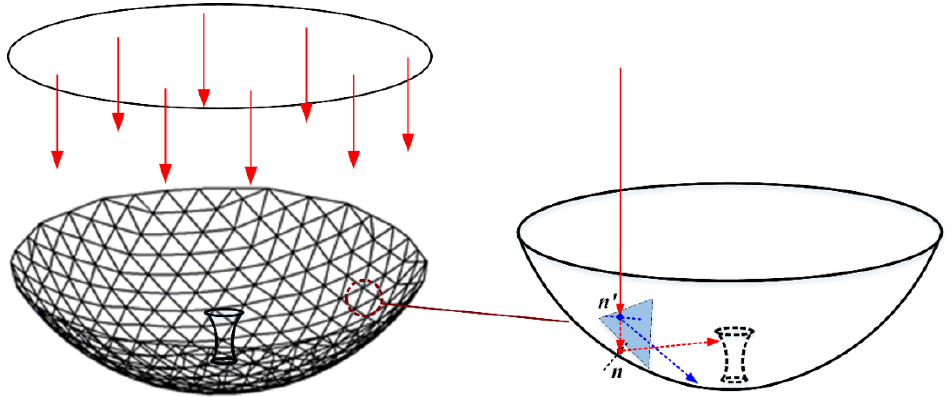
Figure 11. Energy collection and distribution deviation after modularization.